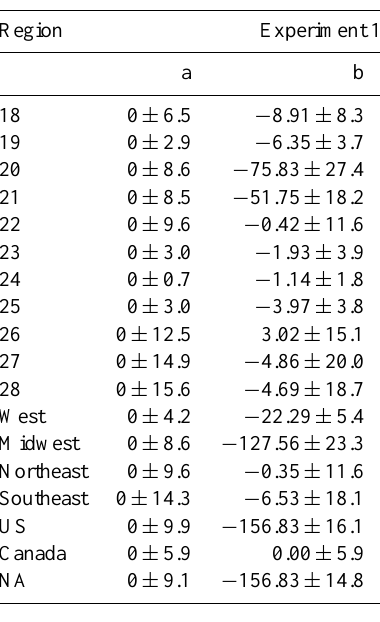
Table 3. Prior fluxes used in the two sets of inversion experiments